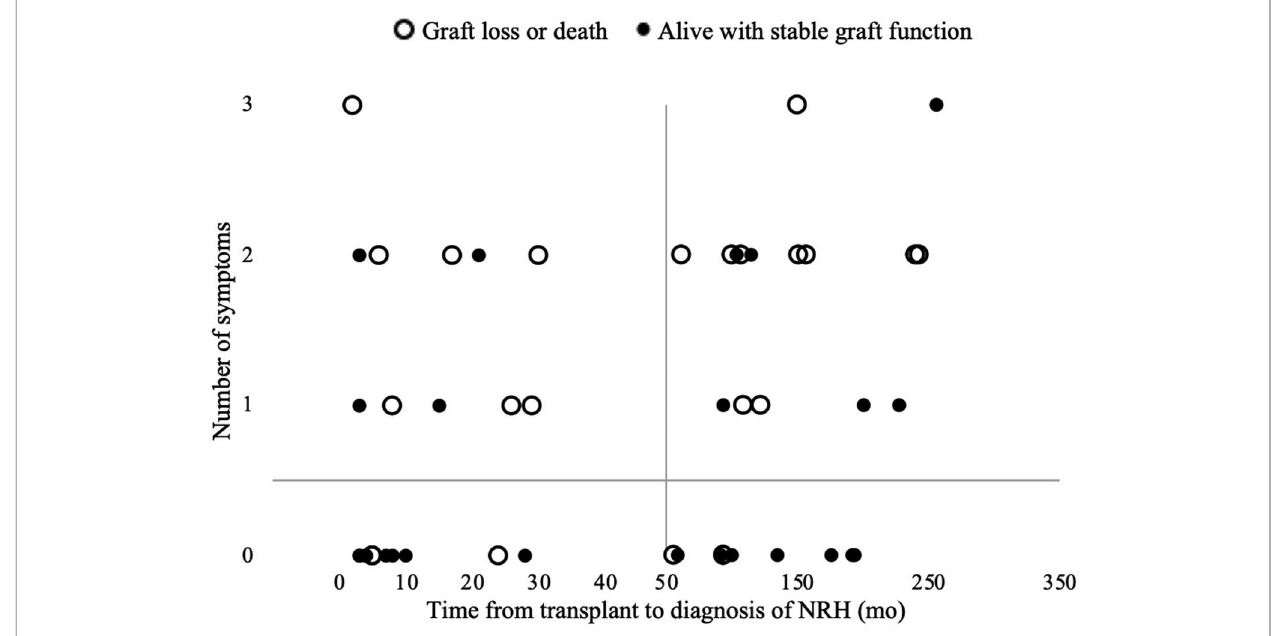
FIGURE 1 | The of number of symptoms of portal hypertension present at diagnosis and time from LT to diagnosis of NRH.